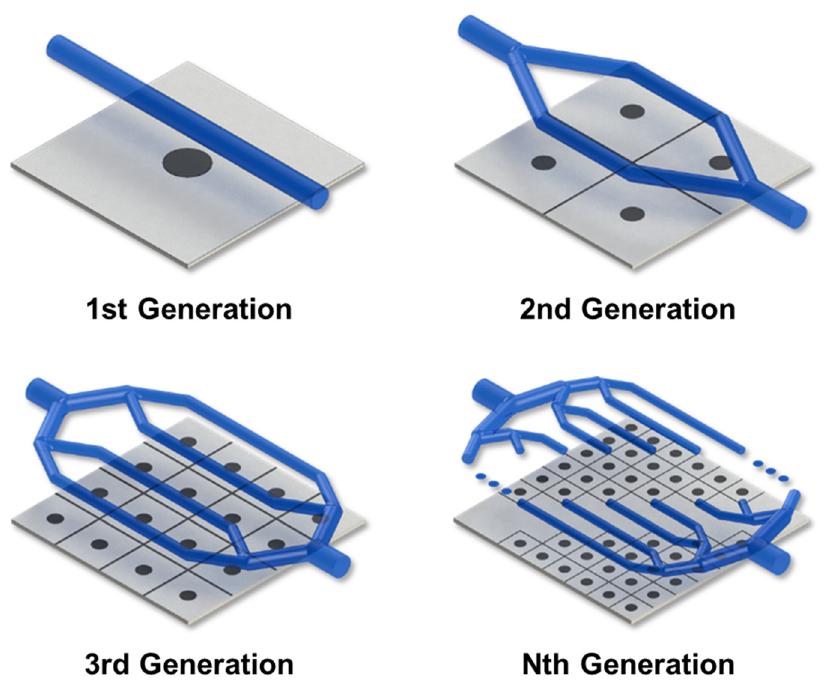
Figure 3. Schematic of the evolution process of the cooling channel.